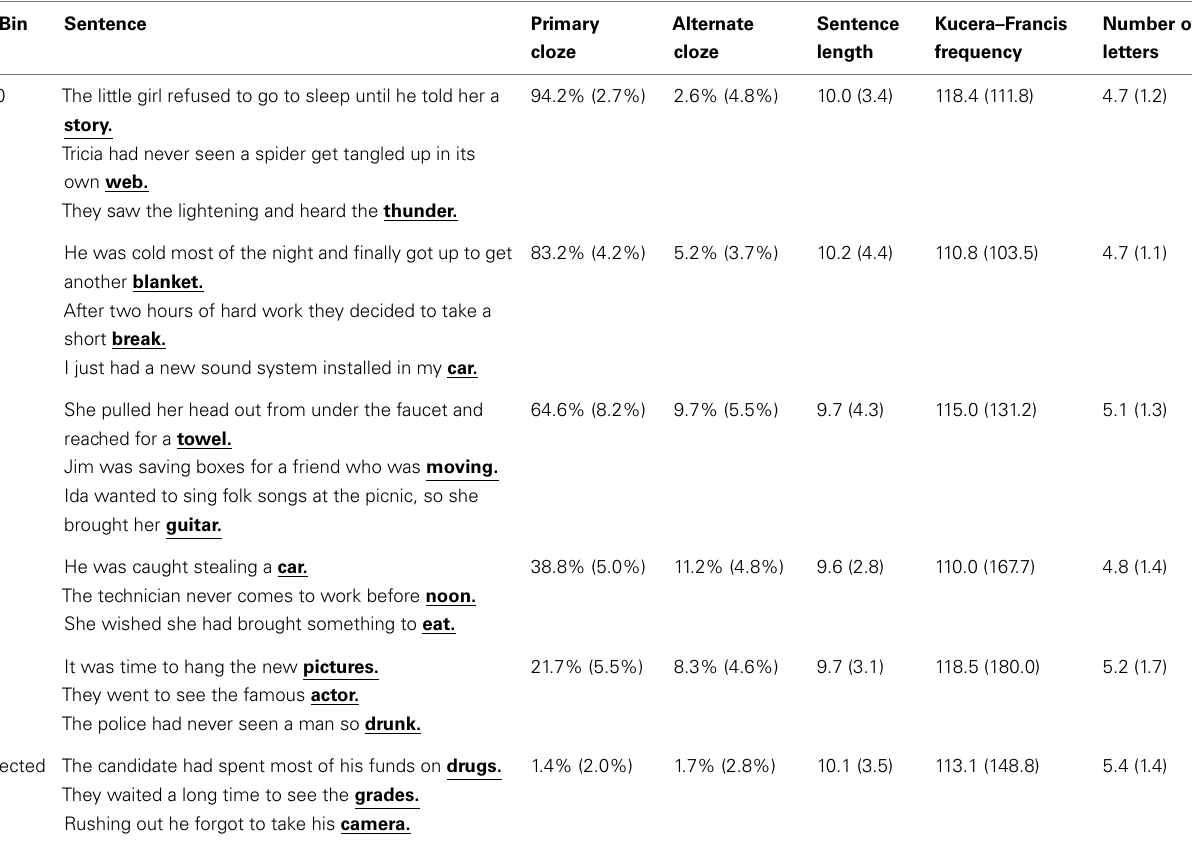
Table 1 | Examples of stimuli and summary characteristics (mean, and standard deviation in parentheses) for the six 50-item cloze probability bins described in the Materials and Methods